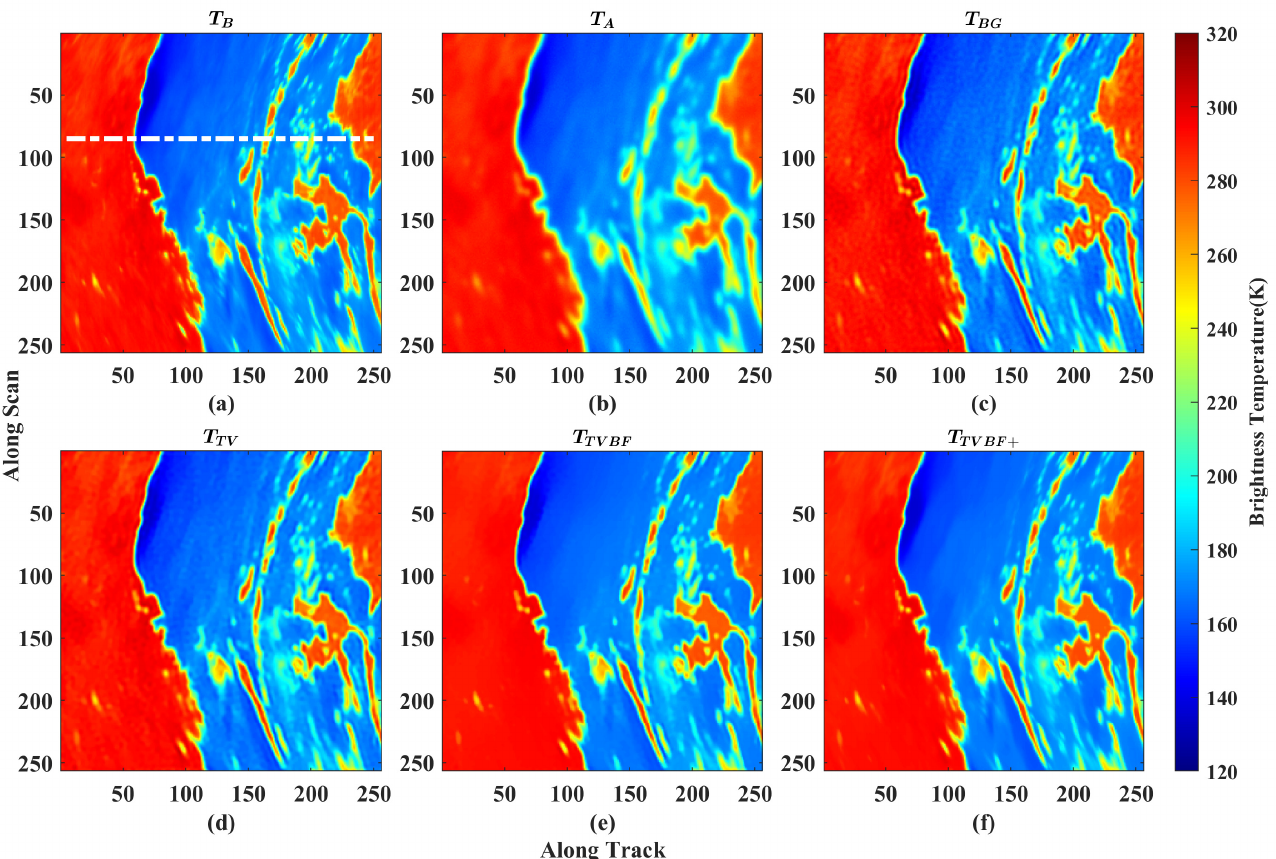
Figure 11. The synthetic MWRI scenario and resolution enhancement results. ( a ) Synthetic 18.7 GHz scene temperature; ( b ) simulated 18.7 GHz antenna temperature; ( c ) the Backus–Gilbert enhance- ment results; ( d ) the TV enhancement results; ( e ) the TVBF enhancement results; ( f ) the TVBF + en- hancement results.